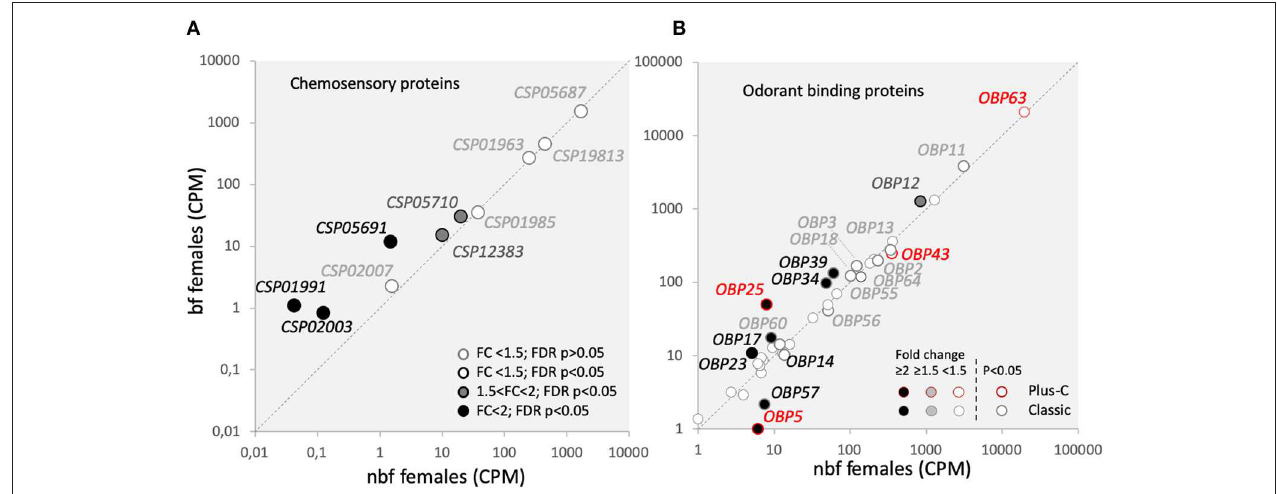
FIGURE 6 | Olfactory binding proteins transcript abundance. Transcript regulation in the maxillary palps of blood fed (bf) and non-blood fed (nbf) Aedes aegypti females is presented as the normalized number of reads of (A) chemosensory proteins ( Csps ); and (B) odorant binding proteins ( Obps ) of two classes, outlined in greyscale and red for classic and plus-C Obps , respectively. Transcripts that exhibit significant differences in abundance (Kal’s test; FDR P < 0.05), are denoted according to their fold change (FC); FC > 2 in black-filled circles; 1.5 < FC < 2 in gray-filled circles; and FC < 1.5 in unfilled circles. The gray dotted line indicates a hypothetical equal transcript abundance between the states. So that (B) is legible, the cutoff for including Obps FC < 1.5 is 25 reads.